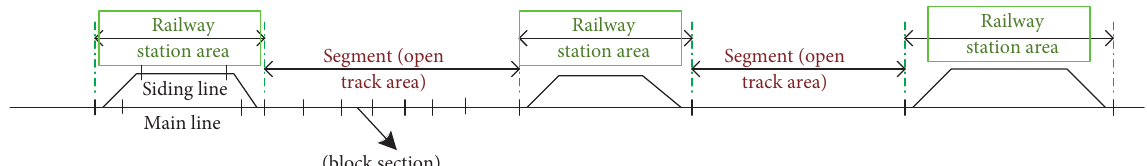
Figure 4: Graphical illustration of notions related to railway track.